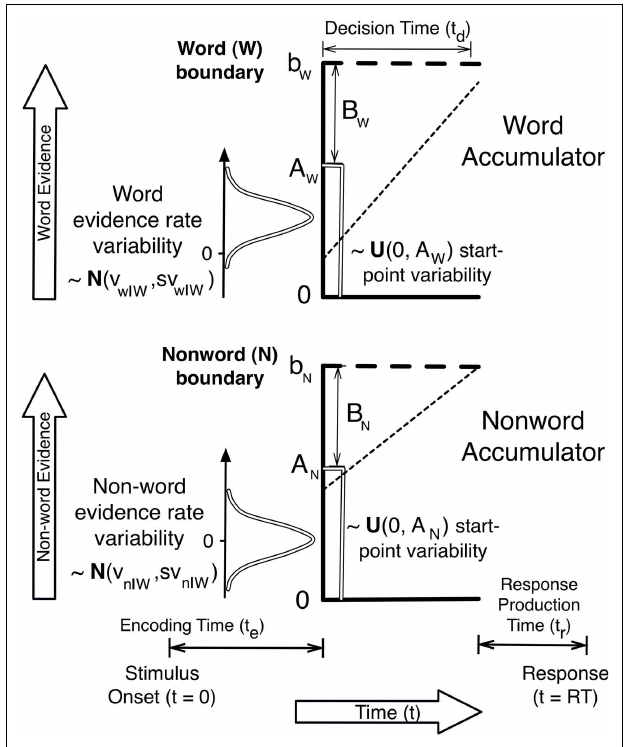
FIGURE 1 |A schematic illustration of an LBA model for the lexical-decision task with a word